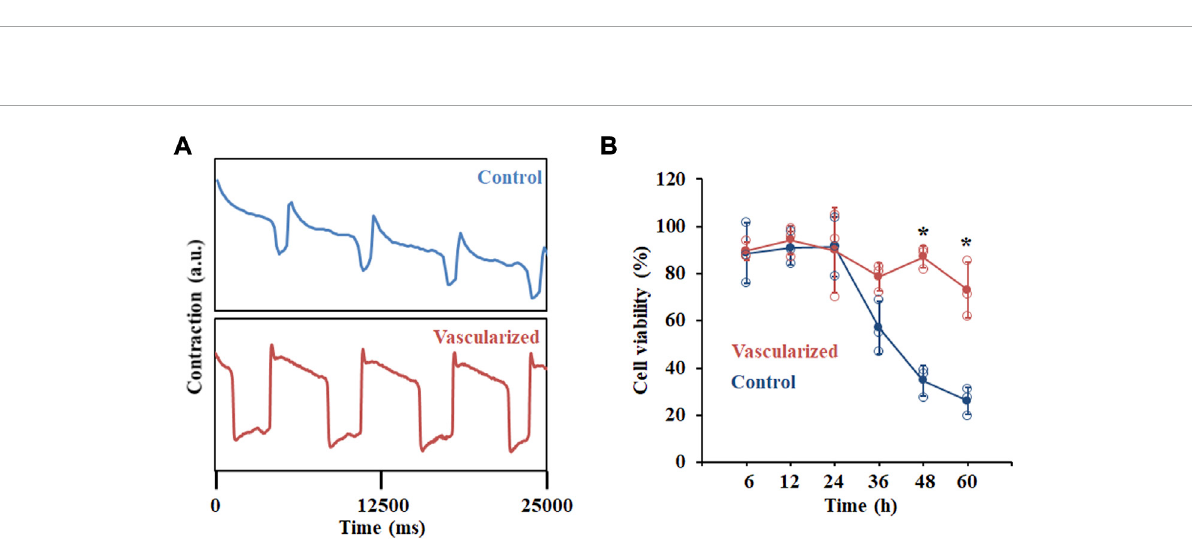
FIGURE 4 Functional analysis of hPSC-derived cardiac organoids. (A) Representative contraction amplitude plots of hPSC-derived cardiac